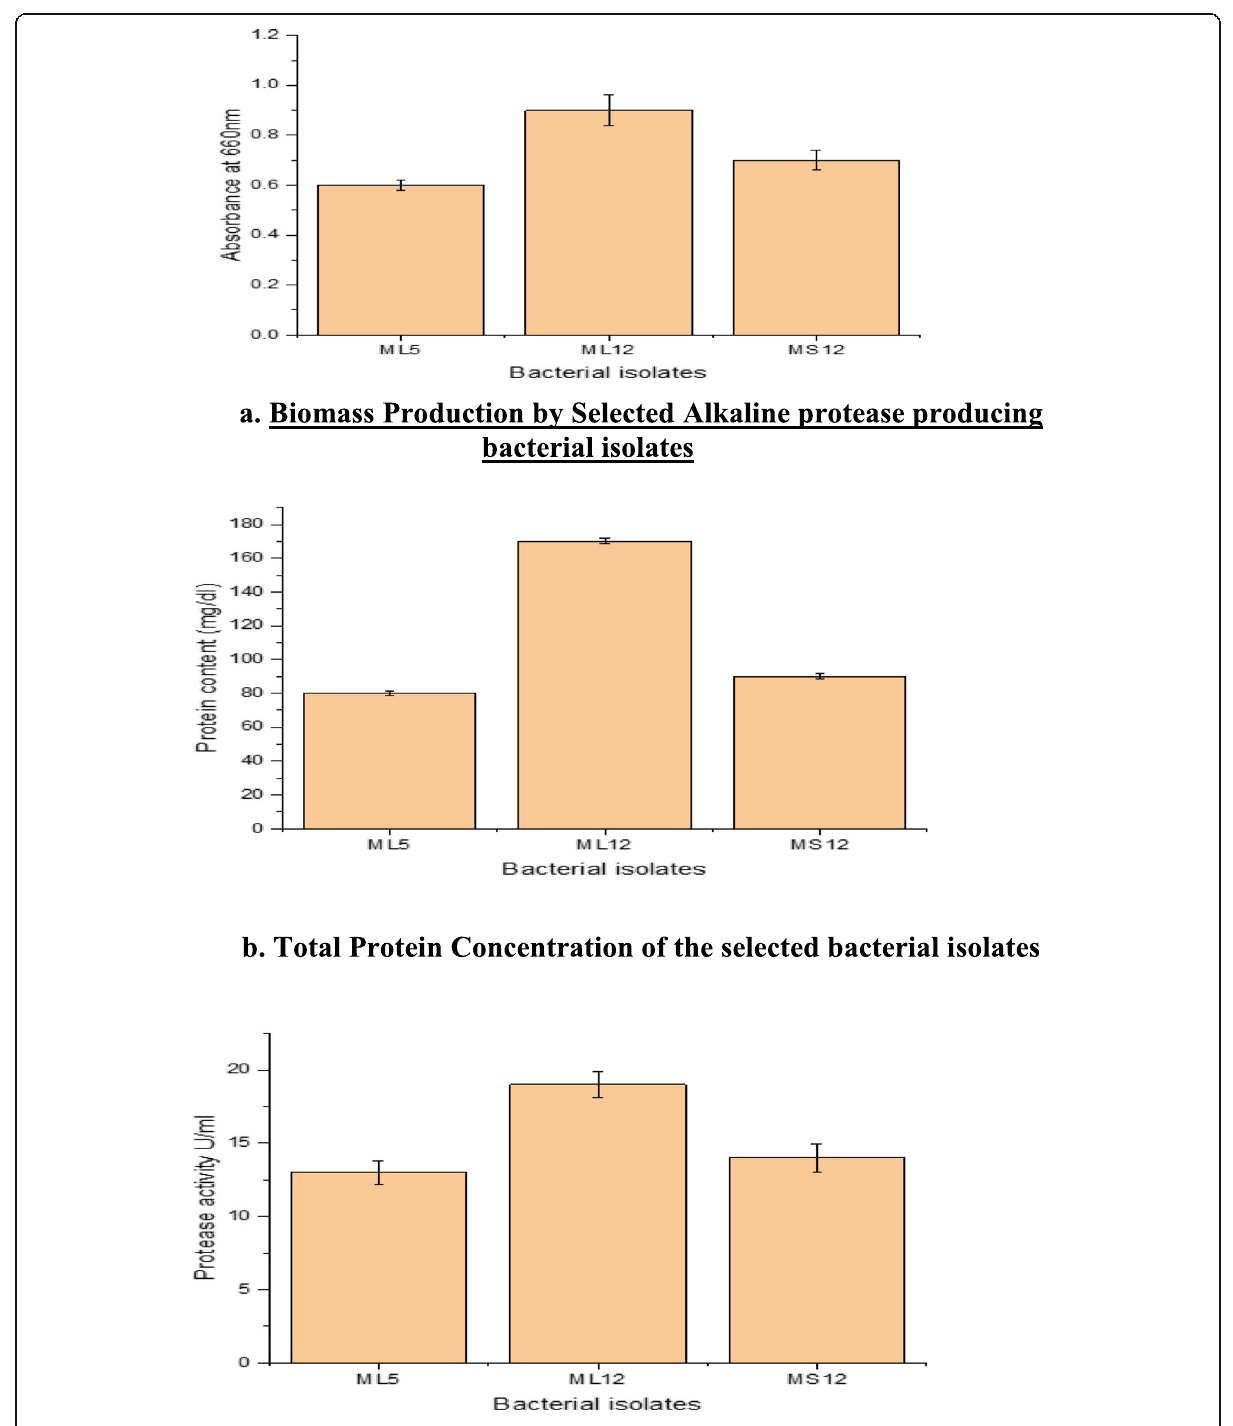
Fig. 4 a Biomass production by selected alkaline protease producing bacterial isolates. b Total protein concentration of the selected bacterial isolates. c Alkaline protease activities of the selected bacterial